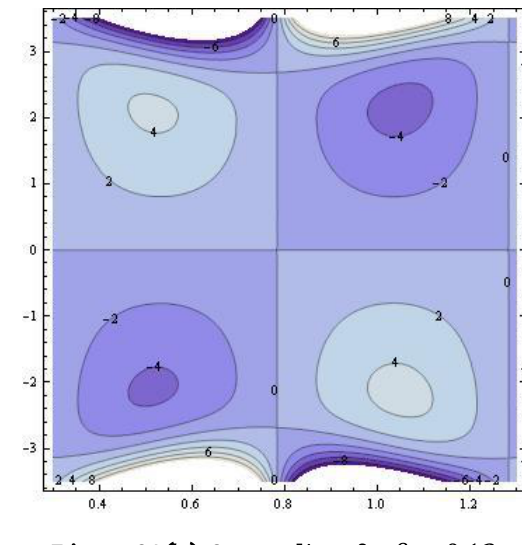
Figure 21(a). Stream lines for 𝛽 = 0.1. Figure 21(b). Stream lines for 𝛽 = 0.12.